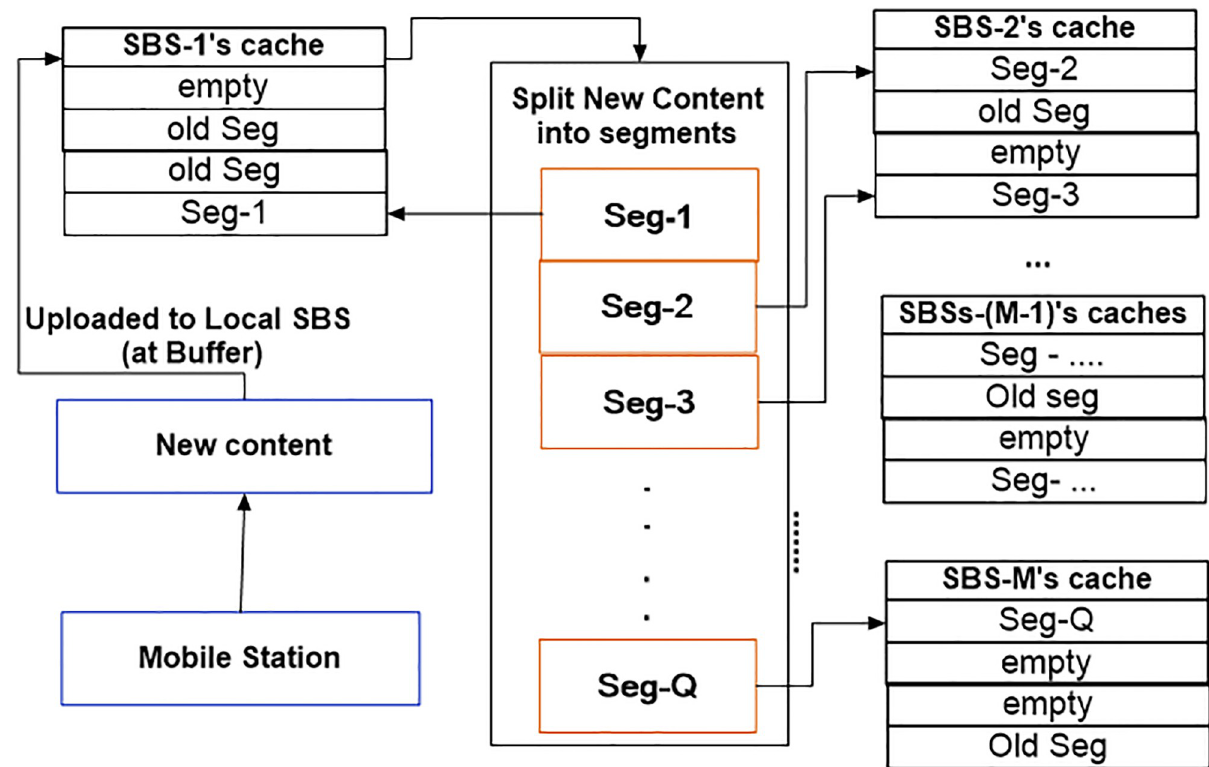
Fig 4. Segmentation of new content across distributed